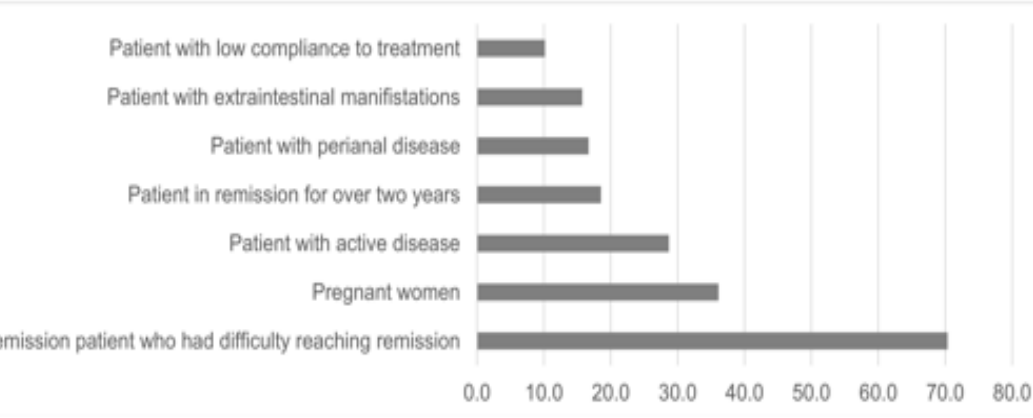
Figure 3. Percentage of the physicians who resist biosimilar switching in different patients’ popula- tions.